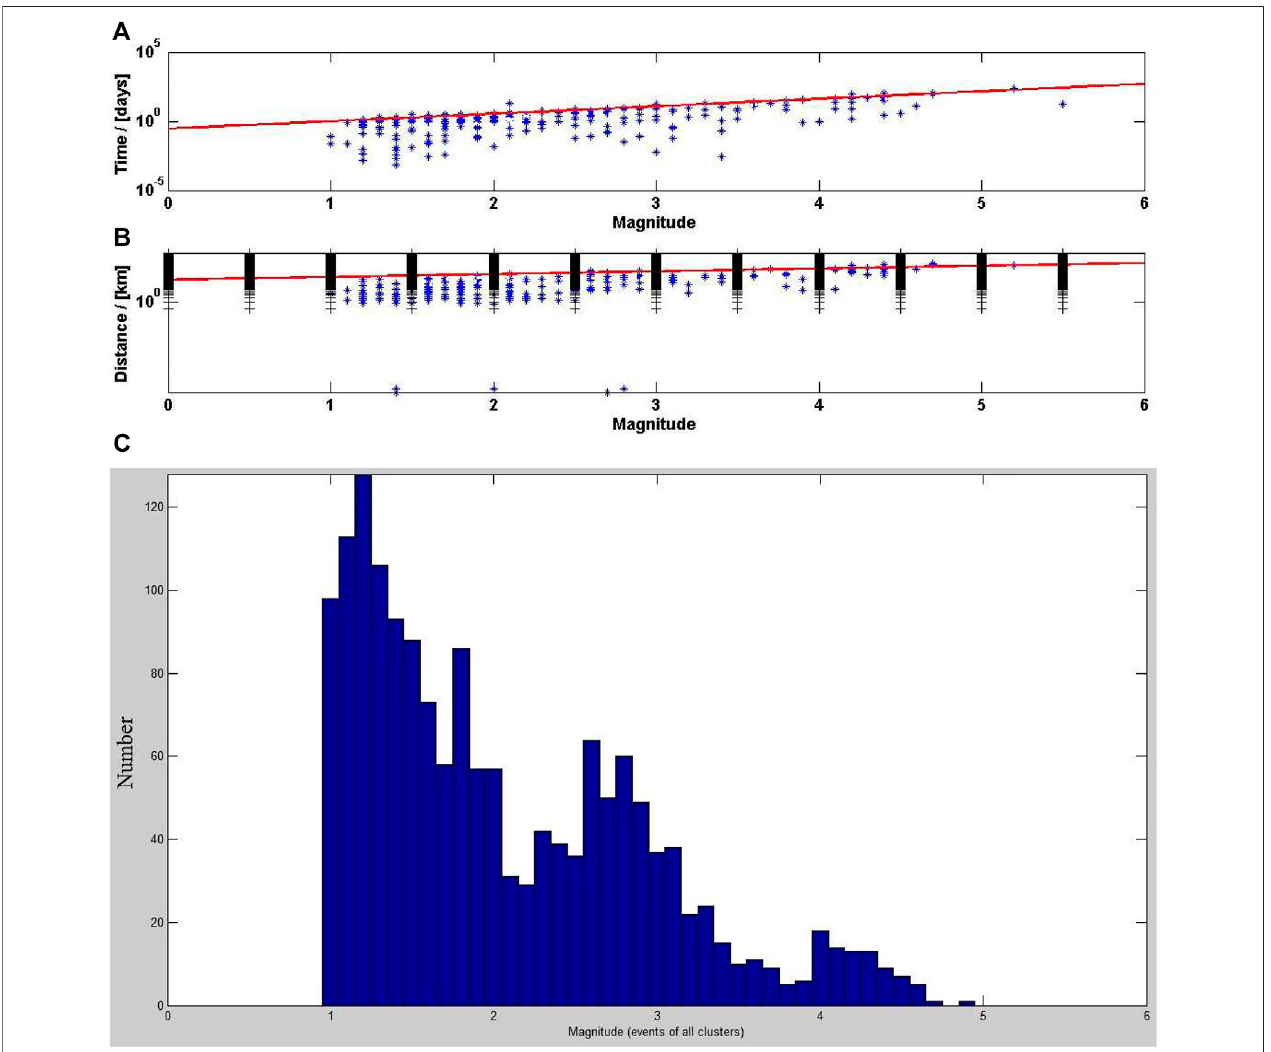
FIGURE 7 | Distribution of events through (A) time and (B) latitude for foreshock, mainshock, and aftershock sequences. (C) The magnitude histogram of the declustered catalog.